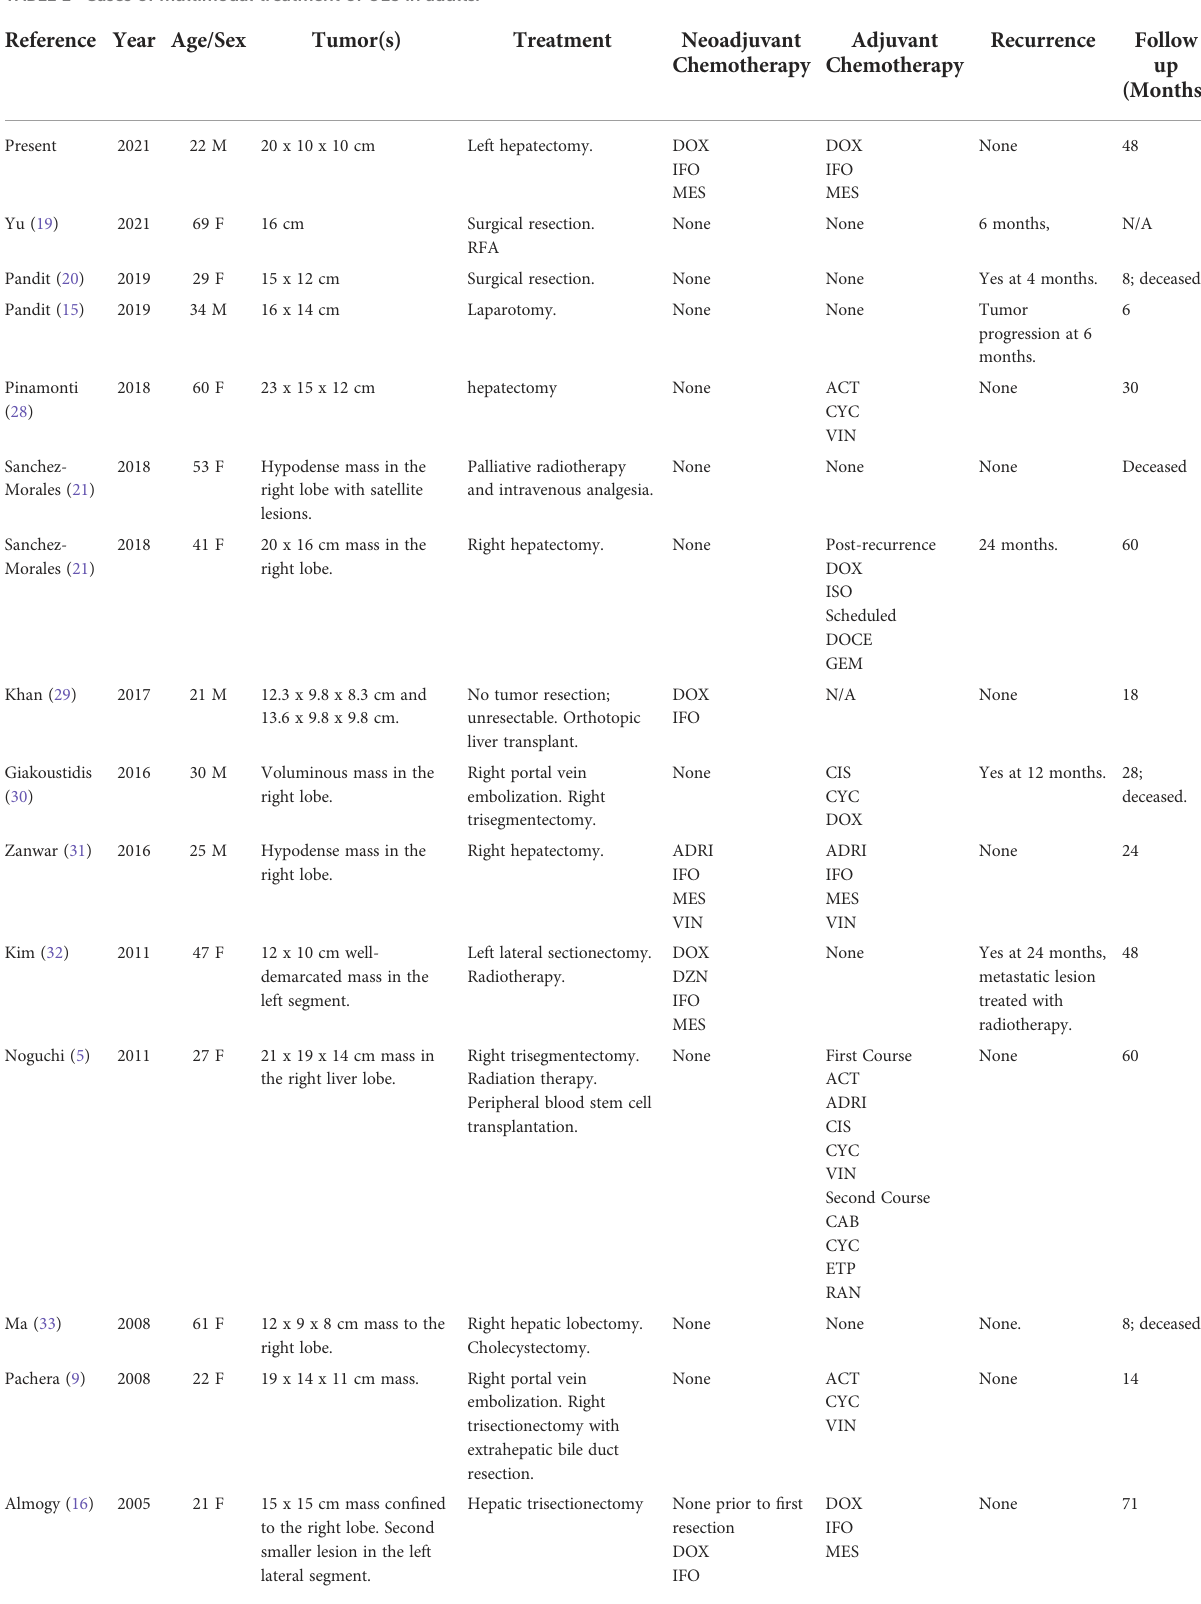
TABLE 1 Cases of multimodal treatment of UES in